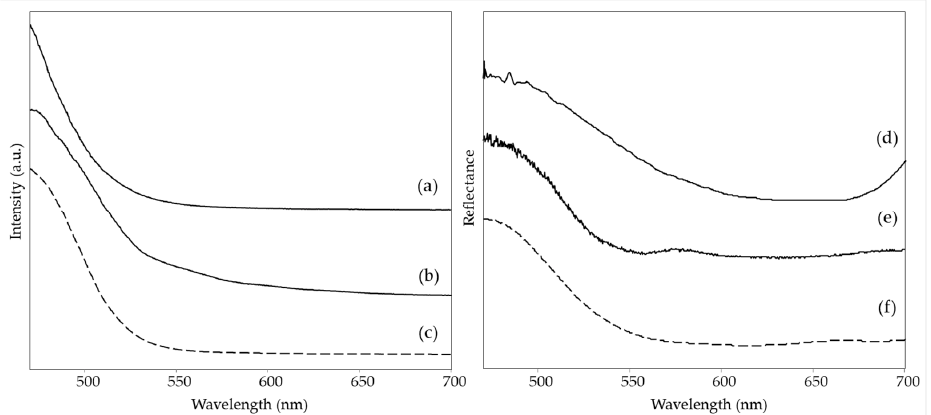
Figure 8. ( Left ) Emission spectra ( λ exc = 435 nm) of blue areas: ( a ) The grammar of fire—Canto II , area 1, ( b ) The North star and the tree of life , area 3, ( c ) reference sample of B029. ( Right ) Visible reflectance spectra of blue areas: ( d ) The grammar of fire—Canto II , area 1, ( e ) The North star and the tree of life , area 3, ( f ) reference sample of B029. Legend: (solid lines) spectra acquired on the paintings; (dashed lines) spectra of reference fluorescent paints.